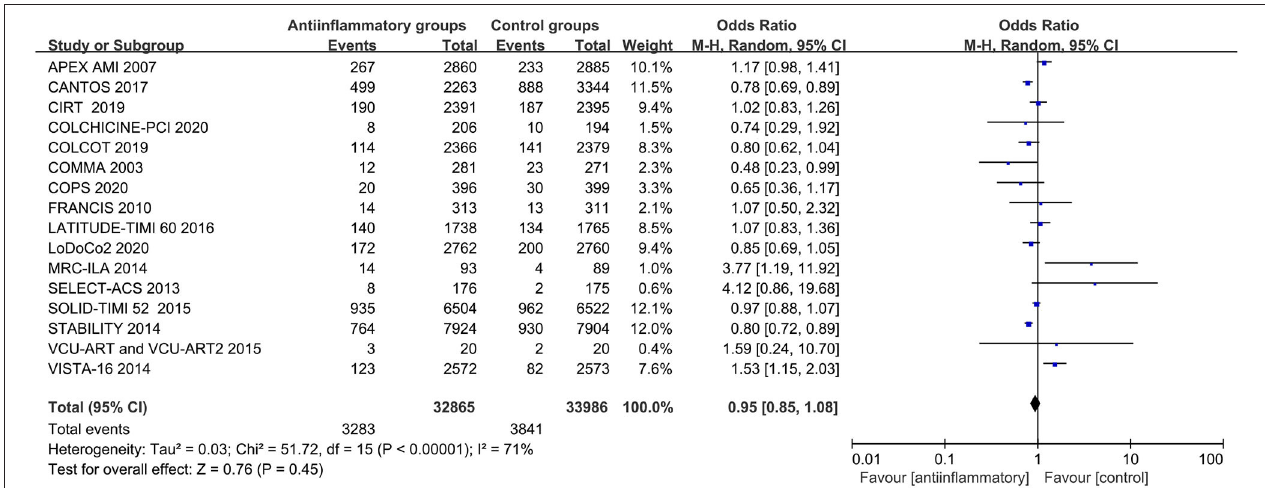
FIGURE 2 | Forest plots of studies evaluating primary end points in patients receiving anti-inflammatory agents vs.